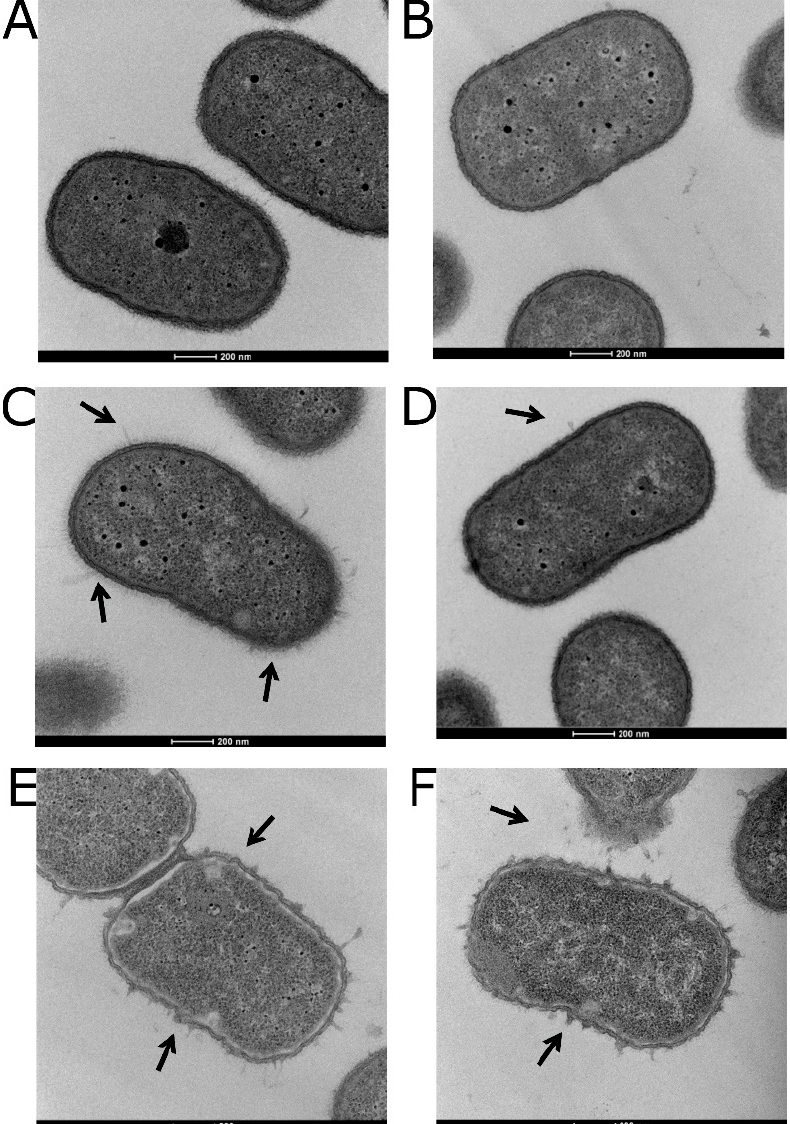
Figure 3. Membrane perturbation of A. baumannii 04117201 (WT) and Δ stkR mutant after colistin stress. WT and Δ sktR mutant strains were subjected to sub-MIC and MIC levels of colistin (3 µg/mL and 12 µg/mL) and cross-sections were examined by TEM (60,000× magnification); 200 nm scale is shown in white. Images are of ( A ) WT, ( B ) Δ sktR , ( C ) WT after exposure to 3 µg/mL colistin, ( D ) Δ stkR after exposure to 3 µg/mL of colistin, ( E ) WT after exposure to 12 µg/mL colistin, and ( F ) Δ stkR after exposure to 12 µg/mL colistin; arrows show membrane perturbation and/or leakage of cellular